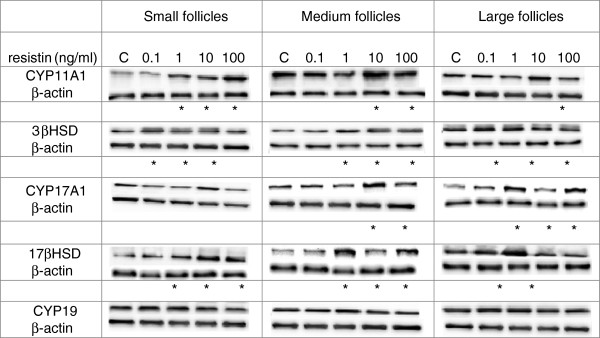
Effects of recombinant human resistin. (0.1, 1, 10, and 100 ng/ml) on the protein expression of steroidogenic enzymes CYP11A1, 3βHSD, CYP17A1, 17βHSD, and CYP19 small, medium and large ovarian follicles. The representative samples of western blots are shown in the panels. Western blot experiments were repeated three independent times using samples from three different animals. Data were plotted as mean±S.E.M. Statistical significance is indicated by * P < 0.05.